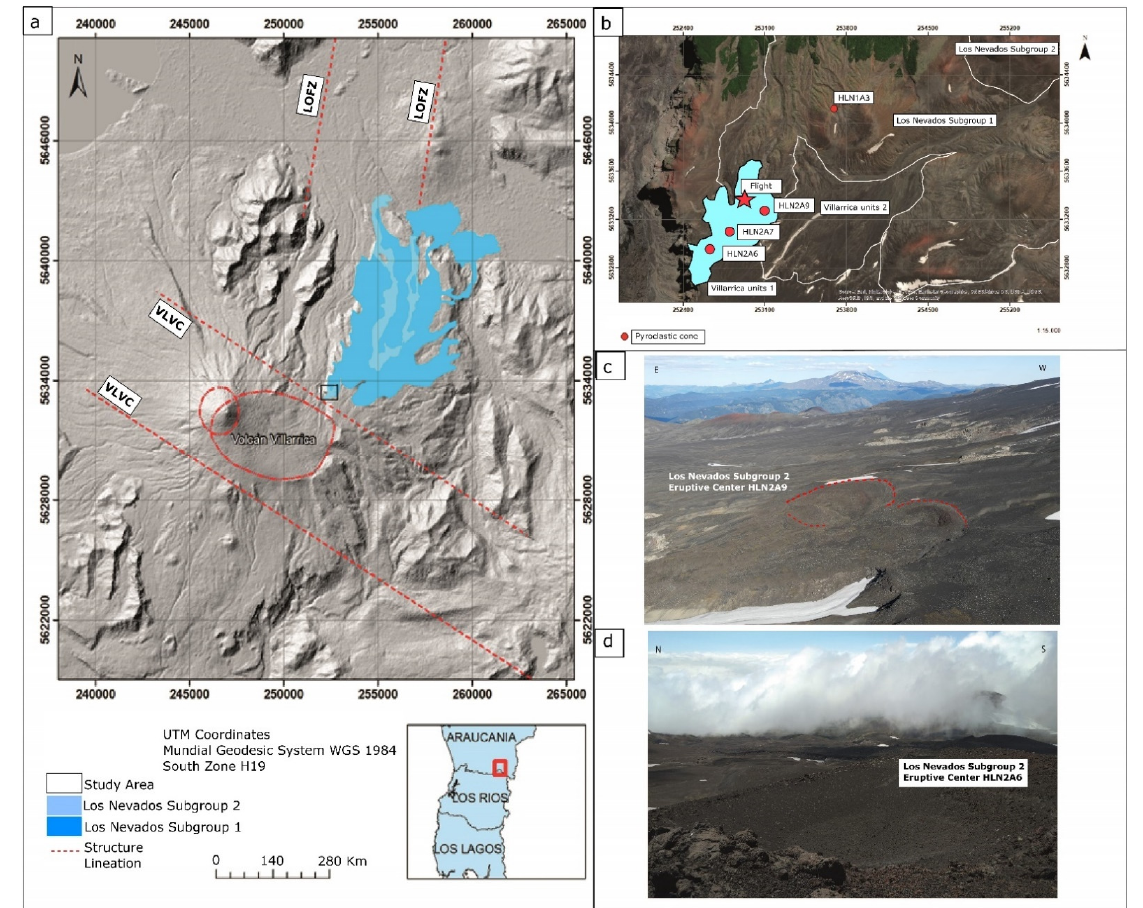
Figure 1. Geographical location of Villarrica volcano and Los Nevados Group. ( a ) Location of Villarrica volcano and distribution of the lithological limits from Los Nevados Group (see Legend). The blue polygons in the image correspond to the study area from Los Nevados Group (Subgroups 1 and 2) and the red dotted line to structure lineations adapted from [3] which were redrawn approximatively and projected in ArcMap 9.3 (ArcGIS software from ESRI). Digital elevation model (DEM) of 12.5 m resolution (DEM ALOS-PALSAR; https://vertex.daac.asf.alaska.edu, accessed on 11 December 2018). Structure lineations VLVC stands for Villarrica–Lan í n Volcanic Chain and LOFZ for Liquiñe–Ofqui Fault Zone. ( b ) Location of emission centers on satellite view with sampling sites (red dots) and lithological contacts from [3]. The blue polygon is Los Nevados Subgroup 2 from the study area. Drone survey taking off site is represented by the red star. ( c ) Specific views of CEM #HLN2A9 from the Drone taking off site. ( d ) Specific views of CEM #HLN2A6 taken from the ground. Photograph courtesy of A.